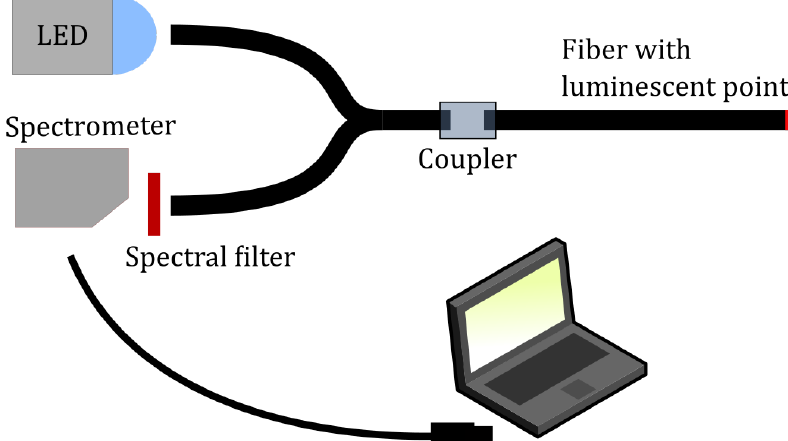
Figure 4. Optical setup for the measurement of photoluminescent intensity from the fabricated sensors. The blue LED is used to excite the luminophores at the distal end of the optical fiber sensor. Emitted photoluminescence propagates back through the system and is directed, through the splitter, to the spectrometer.